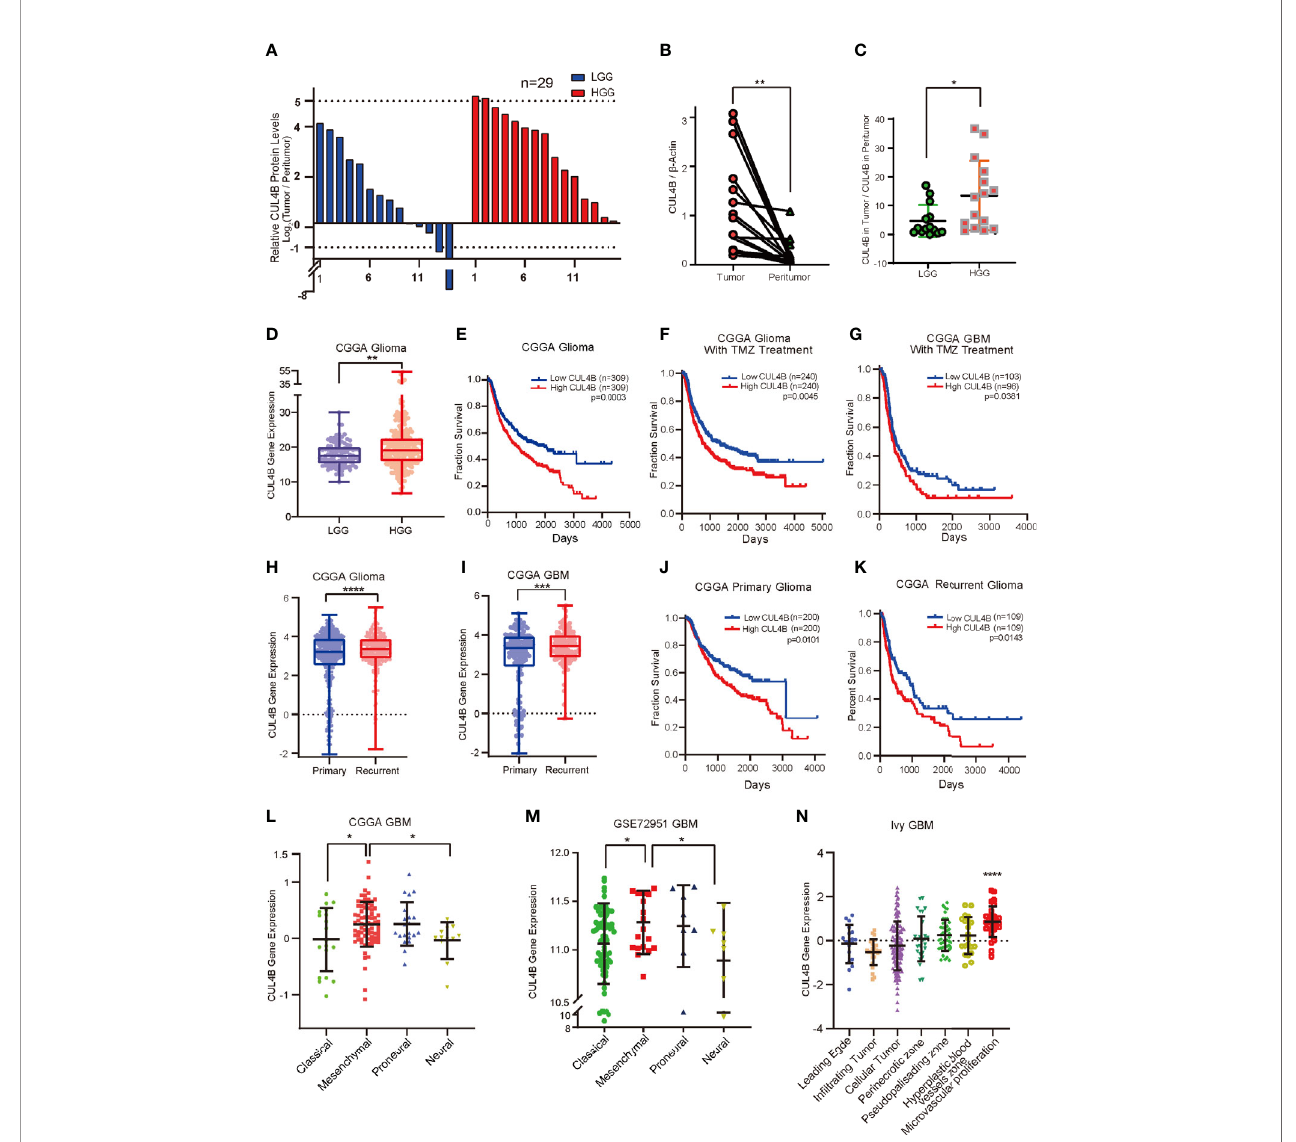
FIGURE 1 | CUL4B expression is upregulated and associated with poor prognosis and TMZ resistance in glioma. (A) CUL4B expression levels in gliomas relative to those in paired non-malignant tissues, as determined by Western blot. (B) CUL4B levels in the HGGs and paired adjacent non-malignant tissues. The value represents the densitometry value of CUL4B band on immunoblots normalized with that of b -actin. (C) CUL4B expression in LGG and HGG patients. The value represents the densitometry value of CUL4B band in tumor tissue compare to that in paratumor on immunoblots normalized to that of b -actin. (D) Expression of CUL4B mRNA in LGG and HGG obtained from the CGGA database. (E – G) Kaplan – Meier analysis with a log-rank test for the overall survival of all glioma patients (E) , glioma patients with TMZ therapy (F) and GBM patients with TMZ therapy (G) from the CGGA database. (H) Expression of CUL4B in primary and recurrent gliomas obtained from the CGGA database. (I) CUL4B mRNA levels in primary and recurrent GBMs obtained from the CGGA database. (J, K) Kaplan-Meier curves for overall survival of primary glioma patients (J) and recurrent glioma patients (K) from the CGGA database. (L, M) CUL4B mRNA expression in four subtypes of GBM obtained from CGGA (L) and GSE27951 (M) dataset. (N) CUL4B expressions in tumor samples from the Ivy Glioblastoma Atlas. Each point corresponds to an individual laser-micro dissected sample. (LGG, low-grade glioma; HGG, high-grade glioma; GBM, glioblastoma; CGGA, Chinese Glioma Genome Atlas. ****P < 0.0001, ***P < 0.001, **P < 0.01, *P <